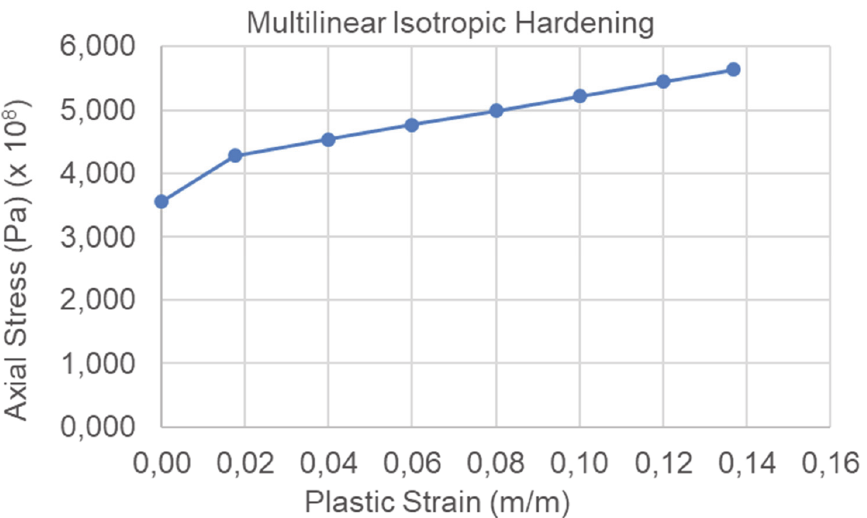
Figure 4: Stress-strain law adopted for structural steel.